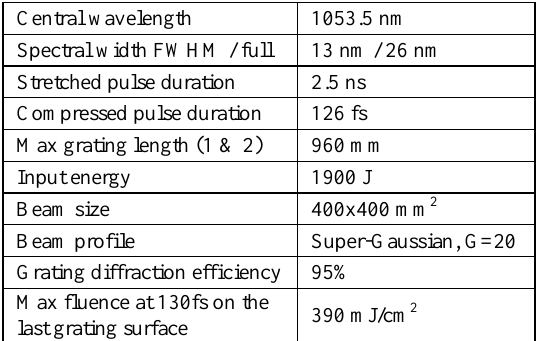
Table 1. Beam parameters used in the design of the